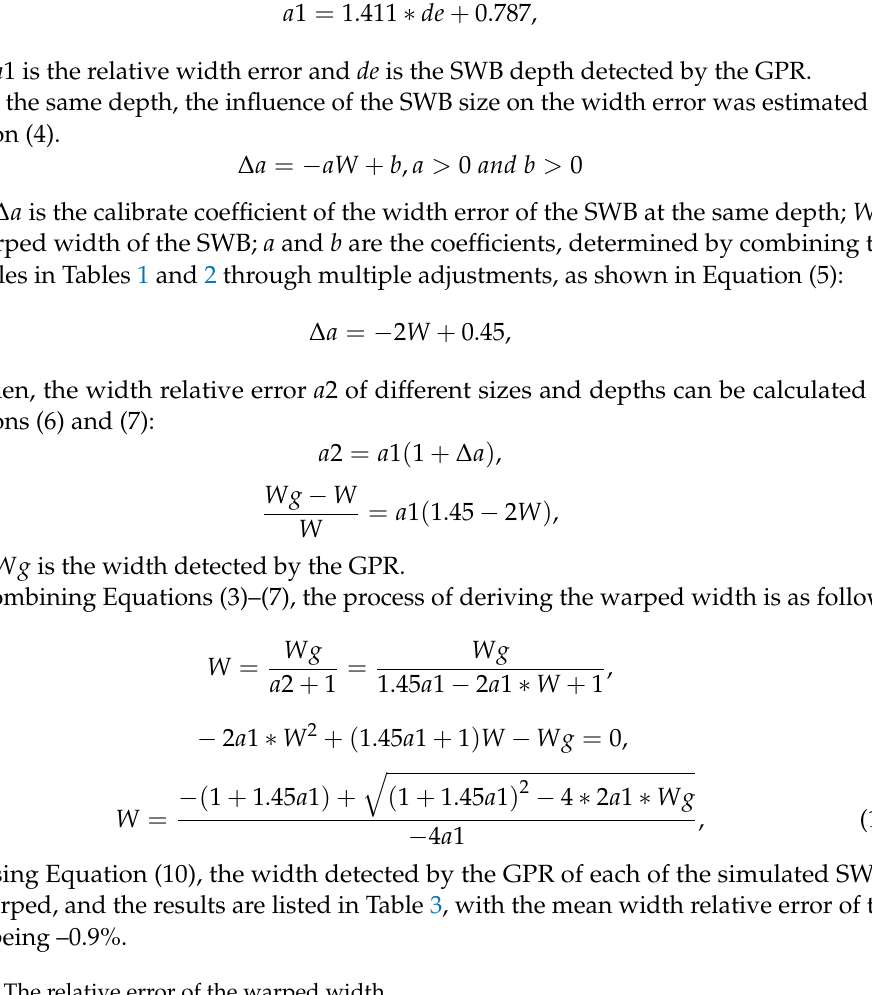
Table 3. The relative error of the warped